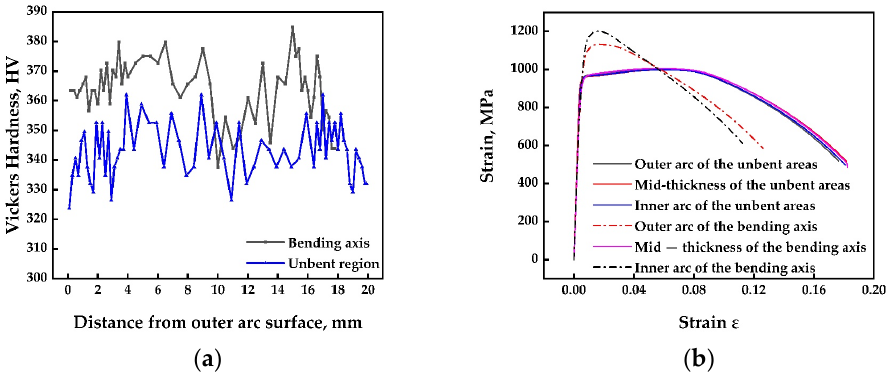
Figure 2. The hardness and tensile curves of the 5% Ni steel samples: ( a ) hardness curves in the thickness direction at different positions from the bending axis, and ( b ) engineering stress–strain curves in the thickness direction of the samples at the bending and unbent zones. Table 2. The tensile test results of the 5% Ni steel samples.